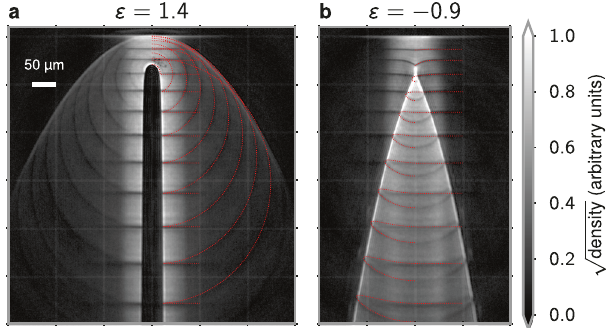
Fig. 6 Fluid- fl ow tracing in the presence of a repulsive or attractive potential. a A repulsive potential with waist σ ≈ 12 μ m is located h = 68.0(5) μ m below the trapped BEC. A small horizontal stripe of atoms (located in the region between the trapped BEC and the potential) is converted back to the 1 ; (cid:2) 1 j i state by a series of brief 100 μ s mw pulses in 0.5 ms intervals, leaving a void of atoms in the imaged 2 ; (cid:2) 2 j i state.